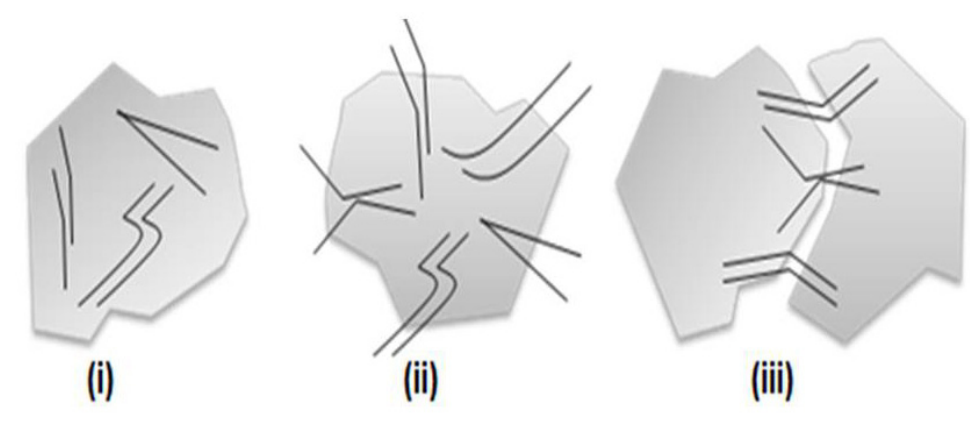
Figure 2. Types of interactions between the steel structure and coke matrix.